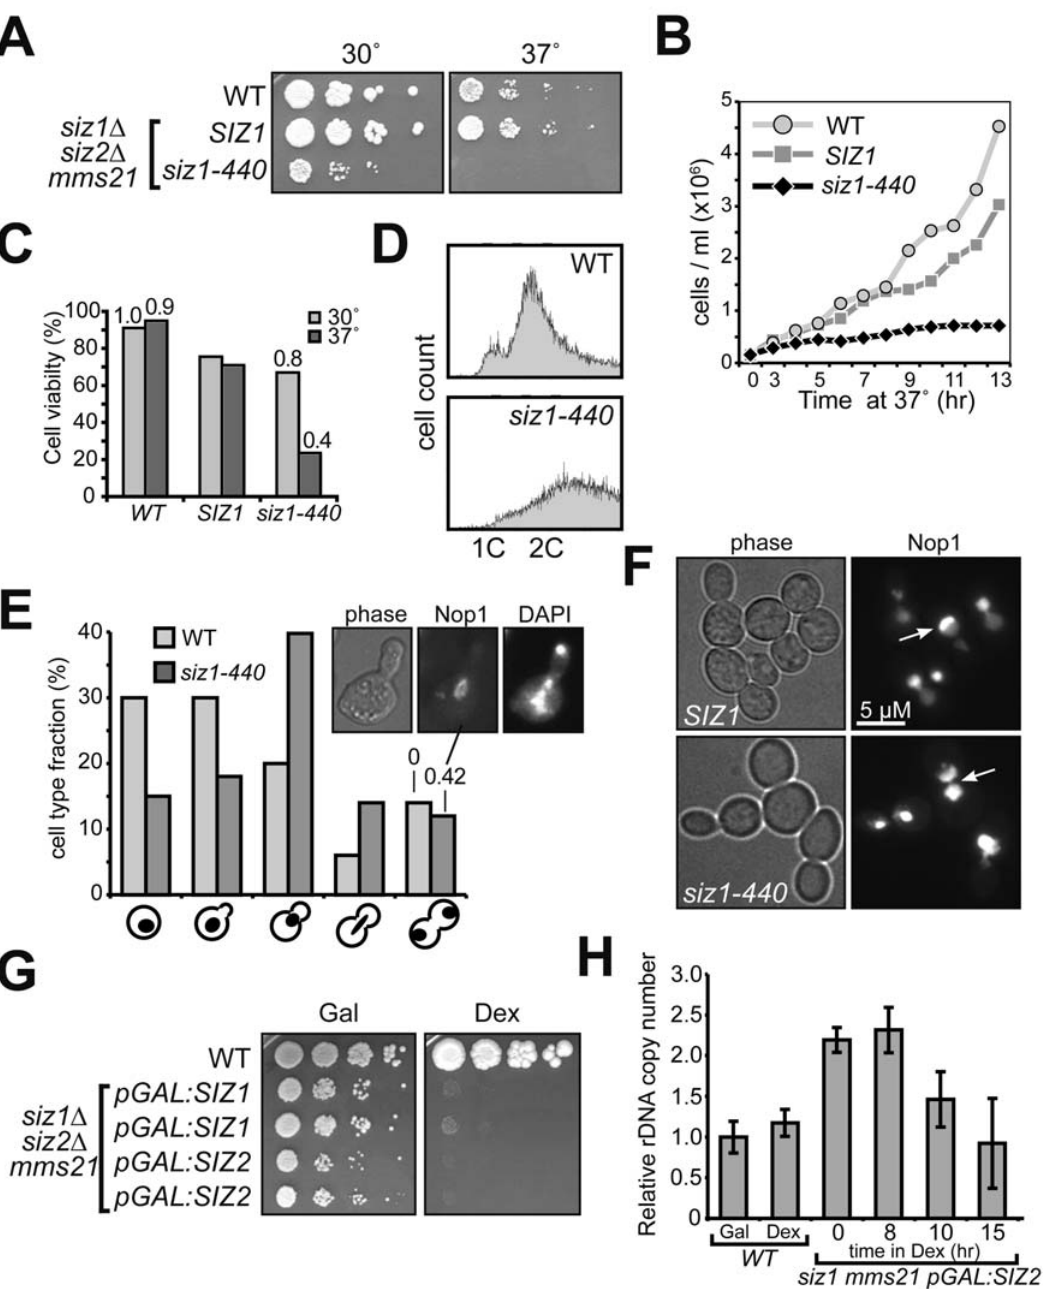
Figure 2. Conditional E3 mutants exhibit defects in rDNA segregation and maintenance. (A) Characterization of a conditional SUMO E3 mutant (E3-ts). The conditional E3 strain (1YT632, siz1 D , siz2 D mms21-CH ) contains siz1-440 encoding a truncated Siz1p that lacks the COOH-terminal region. The control strains shown are wild type ( WT , W303-1A) and a siz1 D siz2 D mms21-CH strain (1cYT628) bearing a full-length SIZ1 plasmid. 10- fold serial culture dilutions were spotted on YPD plates and incubated for 2 days at indicated temperatures. (B) E3-ts cells arrest within two cell divisions at the restrictive temperature. The strains as in (A) were grown exponentially in YPD at 30 u C and shifted to 37 u C at zero timepoint. Cell aliquots were removed at each subsequent time point and cells were counted using a haemocytometer. (C) E3-ts cells lose viability and rDNA copies at non-permissive temperature. The three strains as in (A) were grown in YPD at 30 u C or shifted to 37 u C for 5 hours to determine cell viability by plating assay. The relative rDNA copy number (shown adjacent to viability bars) was determined for wild type and the siz2 D mms21-CH siz1-440 strain as in [11] and normalized to wild type value at 30 u C. (D) The majority of E3-ts mutant cells have replicated DNA. Exponentially growing cells (as in A) were shifted to 37 u C for 5 hours, and DNA content was analyzed by FACS. (E) The nucleolar segregation defect in E3-ts cells at a non-permissive temperature. Haploid E3-ts cells were incubated at 37 u C for 5 hours, stained with DAPI and examined microscopically. Strains were as in 1A, except they contained the nucleolar marker Nop1p-mRFP. The numbers above the bars indicate the fraction of anaphase cells, which have segregated DAPI signals but unsegregated nucleoli (the micrograph shows an example). (F) E3-deficient cells have altered nucleolar morphology. The SIZ1 (NOP1- 1cYT628) and siz1-440 (NOP1-1YT632) strains were treated as in (E). While all SIZ1 cells have proper nucleolar morphology (Nop1-mRFP marker), nucleolar material is more dispersed in E3-ts cells. Similar results were obtained using another nucleolar marker Sik1p-mRFP (not shown). (G) SIZ1 or SIZ2 transcription shut-off in the siz1 D siz2 D mms21-CH strain leads to growth arrest. Cultures of triple-mutant ( siz1 D siz2 D mms21-CH ) strains carrying